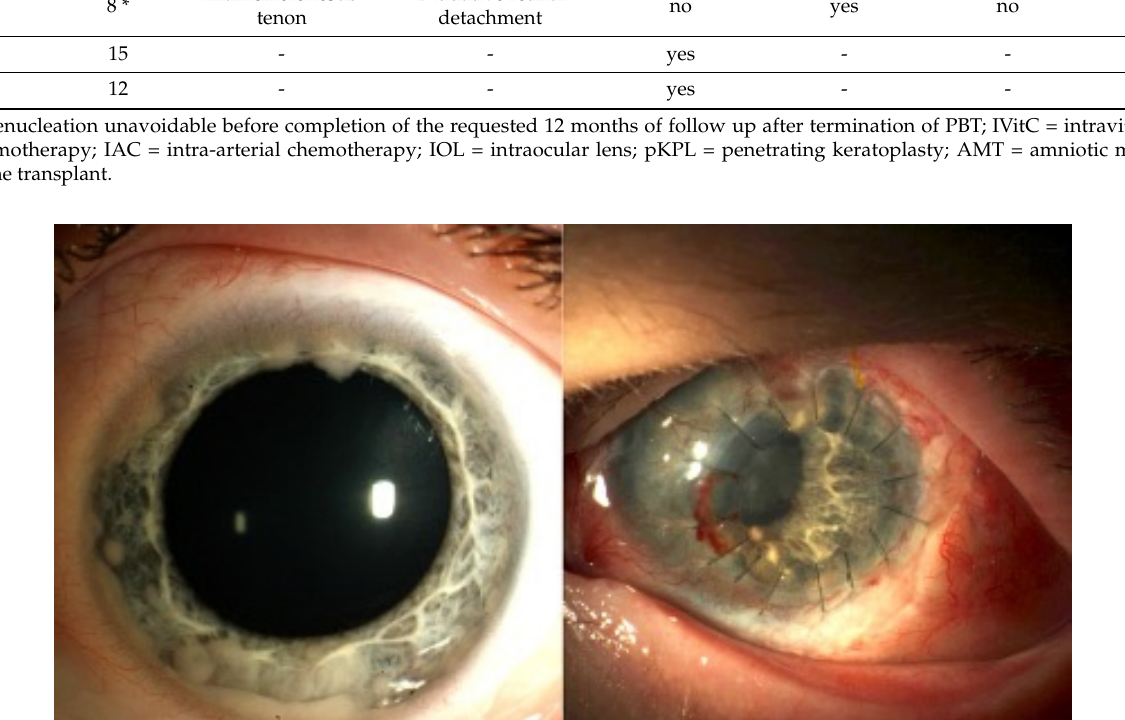
Figure 3. (Case 7): The first picture shows the anterior segment involving tumor recurrence. This was a late recurrence with the initiation of proton therapy at 97 months of age. The tumors showed total regression. However, the child suffers from chronic ocular surface disease due to anterior segment radiation. Emergency keratoplasty had to be performed 19 months after proton beam therapy due to a perforated corneal ulcer. Even after transplantation the eye shows recurrent corneal erosions.